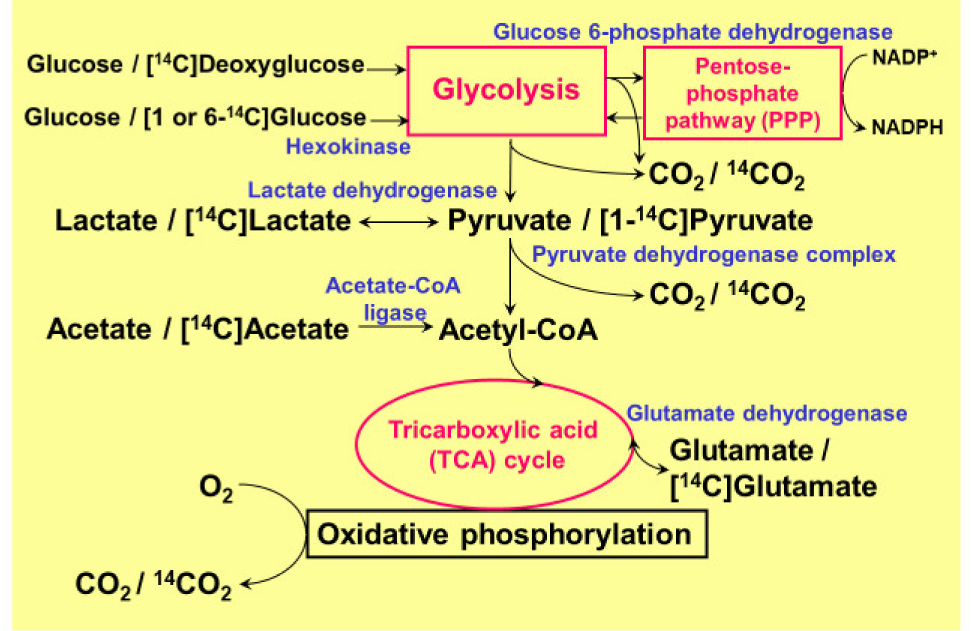
Figure 1. Pathways of glucose metabolism and 14 C-tracers used in quantitative metabolism. The main pathway of ATP generation from glucose in the brain, especially in neurons, depends on oxidative phosphorylation in the tricarboxylic acid (TCA) cycle. In astrocytes, however, glycolysis dominates, and glucose flux into its shunt pathway, the pentose-phosphate pathway (PPP), is five to seven times higher than in neurons. The PPP plays an important role in generating a reduced form of nicotinamide adenine dinucleotide phosphate (NADPH) from the oxidized form (NADP + ). Although the oxidation of [ 14 C] lactate or [ 14 C] pyruvate and the production of 14 CO 2 is much lower (1/6–1/4) in astroglia than in neurons, astroglial [ 14 C] glutamate oxidation is much higher, suggesting normal mitochondrial